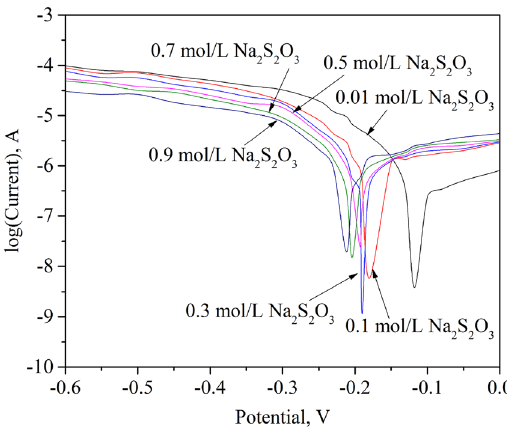
Figure 1: Tafel plots of gold dissolution at di ff erent S 2 O 32 −